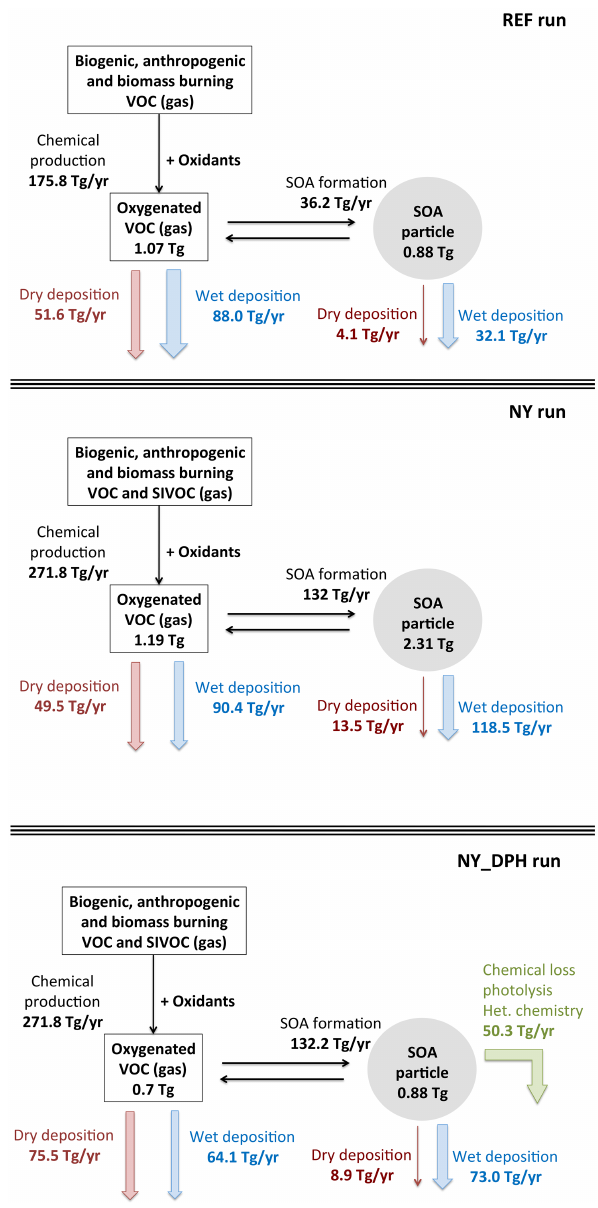
Figure 8. Global budgets (sources/sinks Tgyr − 1 and burden Tg) of condensable secondary organic gas and particle compounds as predicted by the GEOS-Chem REF, NY and NY_DPH simulations for